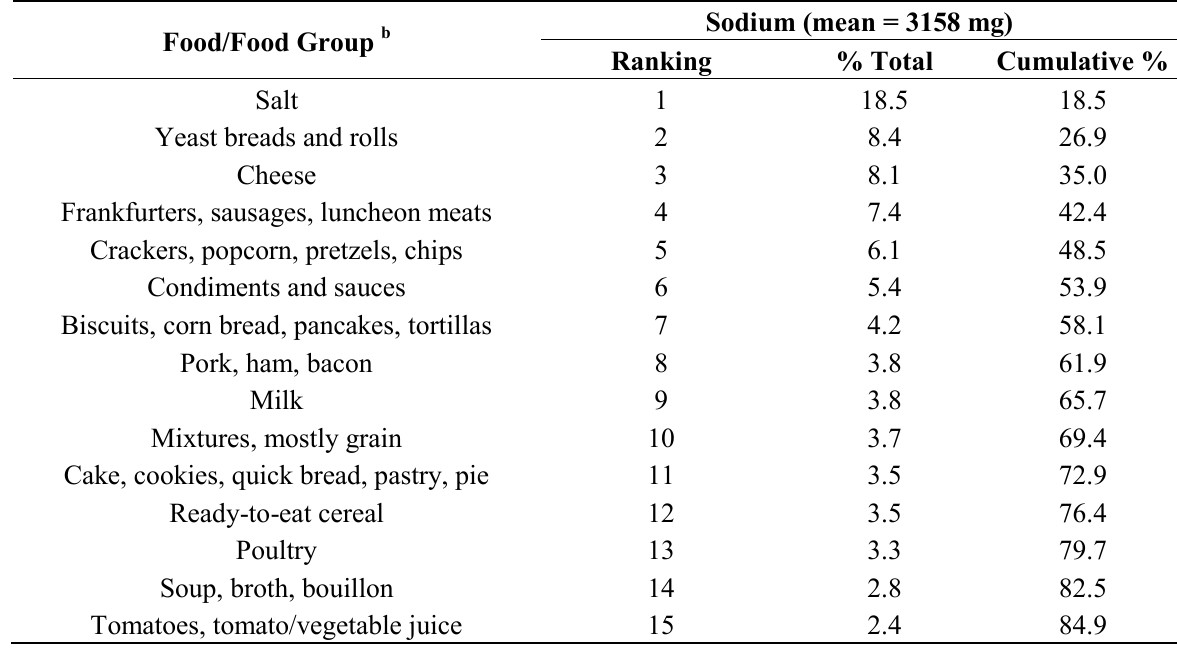
Table 13. Food/Food group sources of sodium among US children aged 2–18 years (from NHANES 2003–2006) a